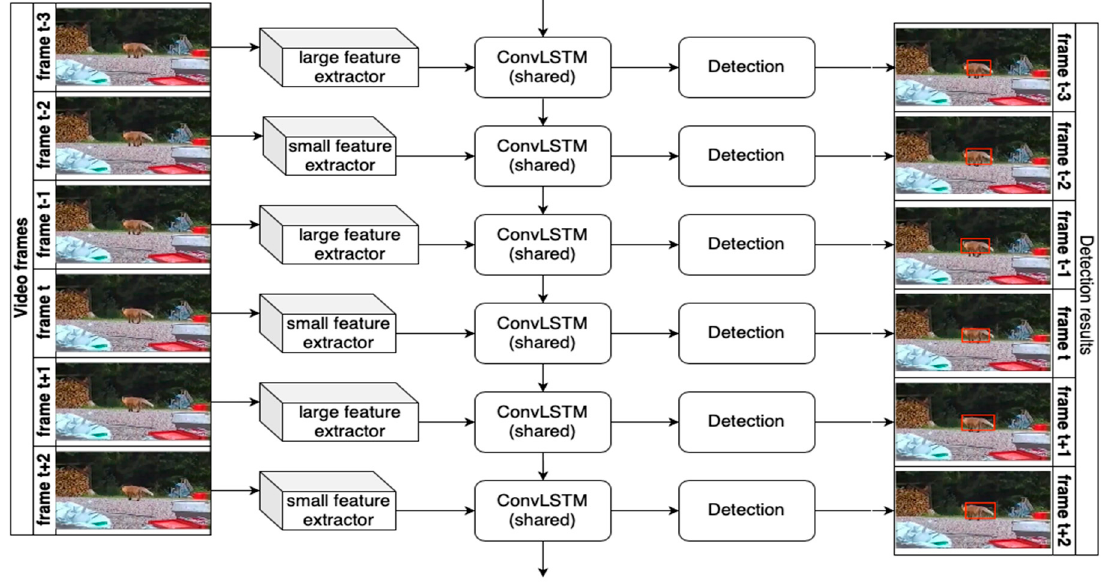
Figure 5. Small and large feature extractors in [70].